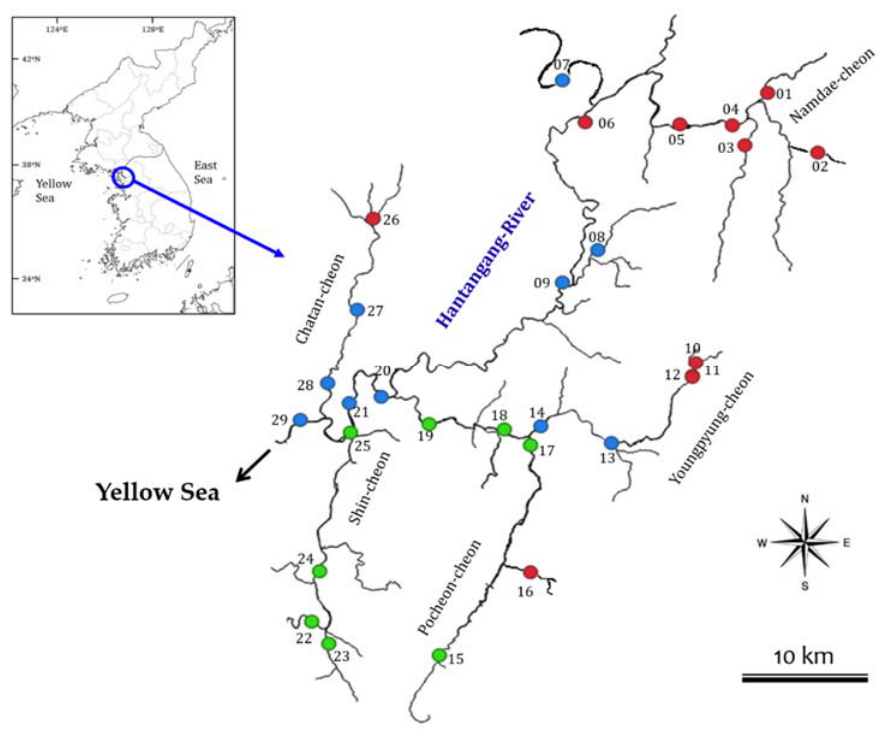
Figure 1. Map of the sampling sites in the Hantangang River in South Korea for epilithic diatom and water analysis. Sampling has been conducted twice a year between 2012 and 2015. Color circles indicate the sampling sites of three groups, such as G1 (red), G2 (blue) and G3 (green). Groups were divided by a cluster analysis (see Results section).